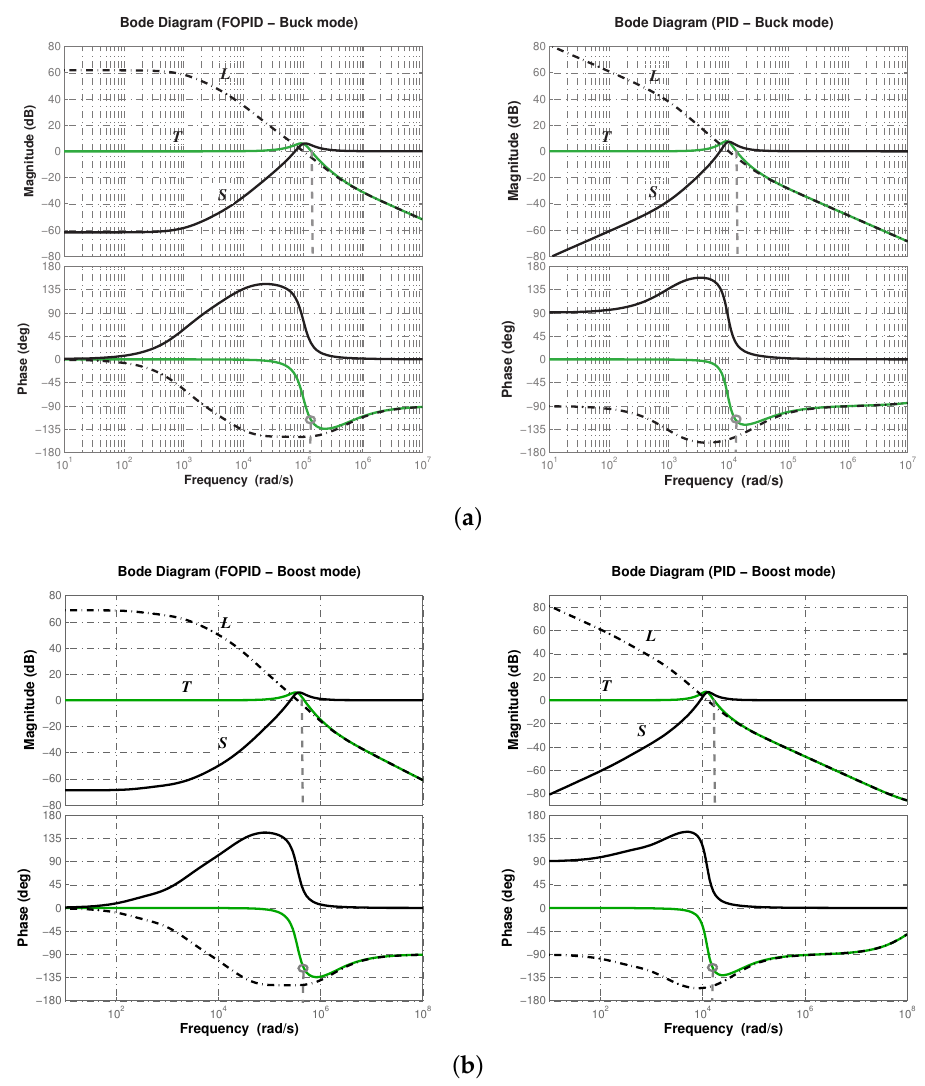
Figure 7. Frequency response of sensitivity S , complementary sensitivity T functions and loop gain L for both ( a ) buck and ( b ) boost conversion